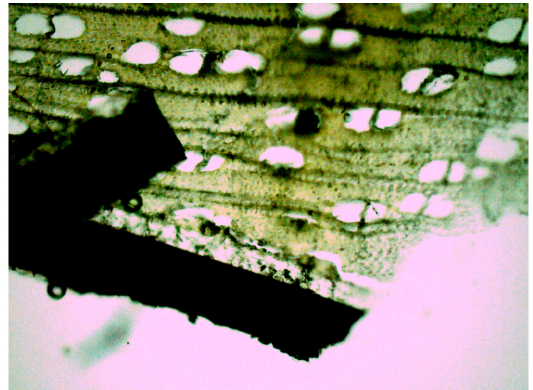
Figure 1. Micrograph of cross section of the paint film.